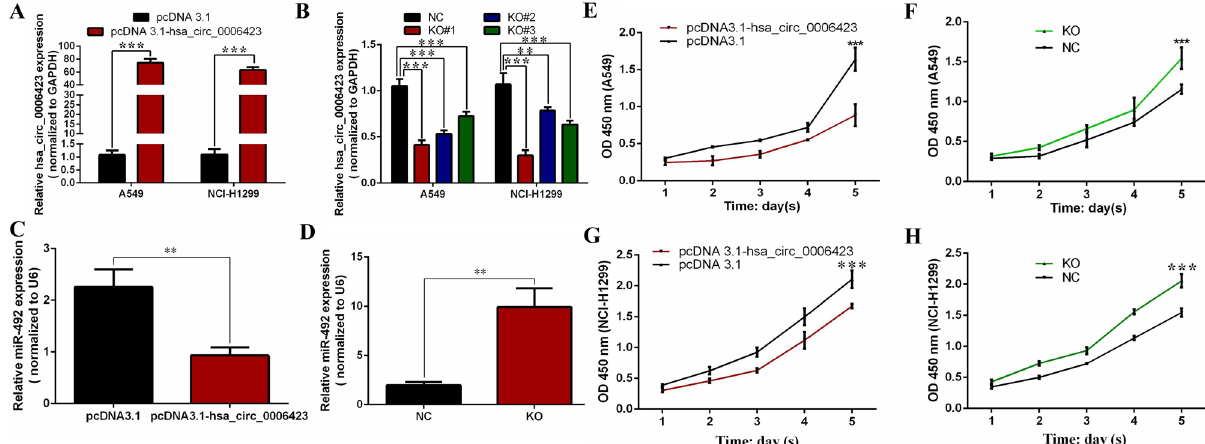
Figure 5. Expression levels of hsa_circ_0006423 after upregulation and downregulation of hsa_circ_0006423; effects of hsa_circ_0006423 on NSCLC proliferation. ( A ) Upregulation effect of hsa_circ_0006423 overexpression plasmid in NSCLC cells. ( B ) siRNA downregulation effect of hsa_circ_0006423 in NSCLC cells. ( C ) Expression level of miR-492 before and after overexpression of hsa_circ_0006423. ( D ) Expression level of miR-492 before and after knockdown of hsa_circ_0006423. ( E ) Grow curve of A549 cells following overexpression of hsa_circ_0006423. ( F ) Grow curve of A549 cells following silencing of hsa_circ_0006423. ( G )